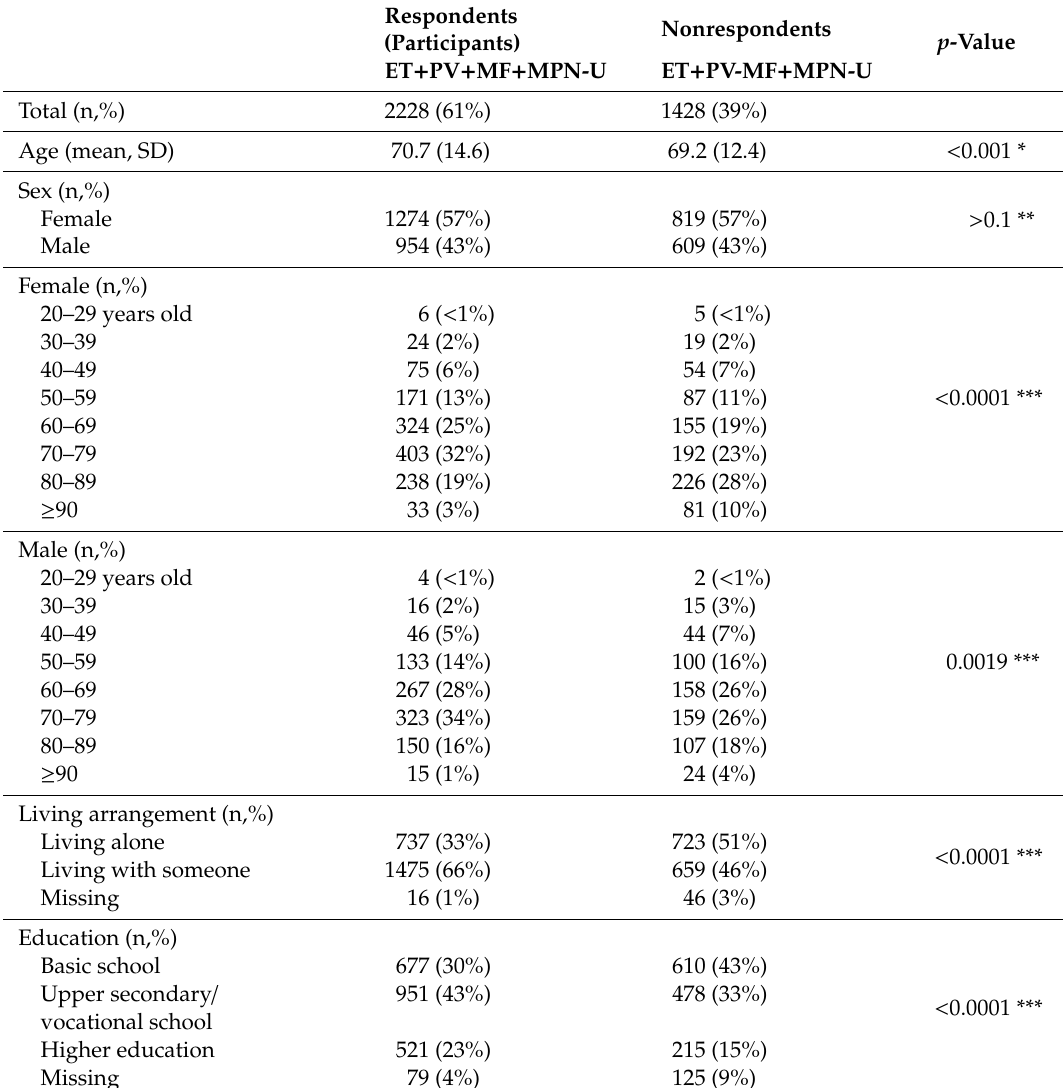
Table 1. Characteristics of respondents and